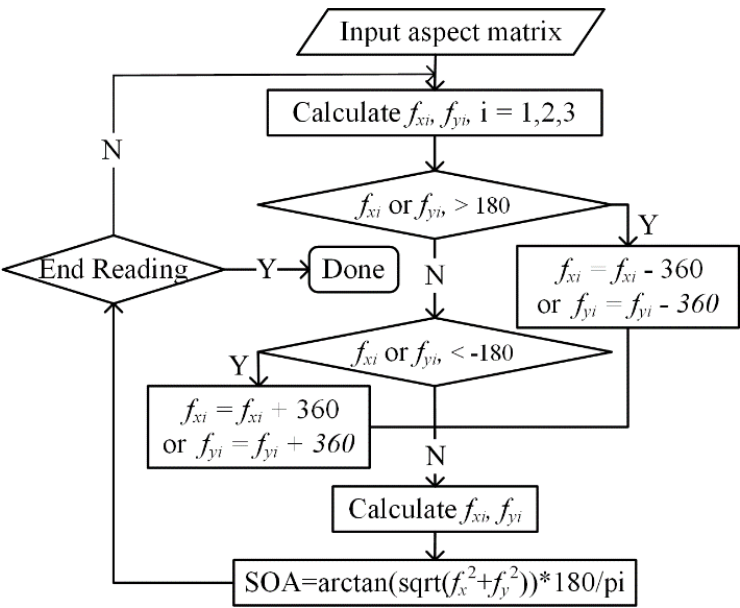
Figure A1. Flowchart of the senary method for calculating SoA [24].